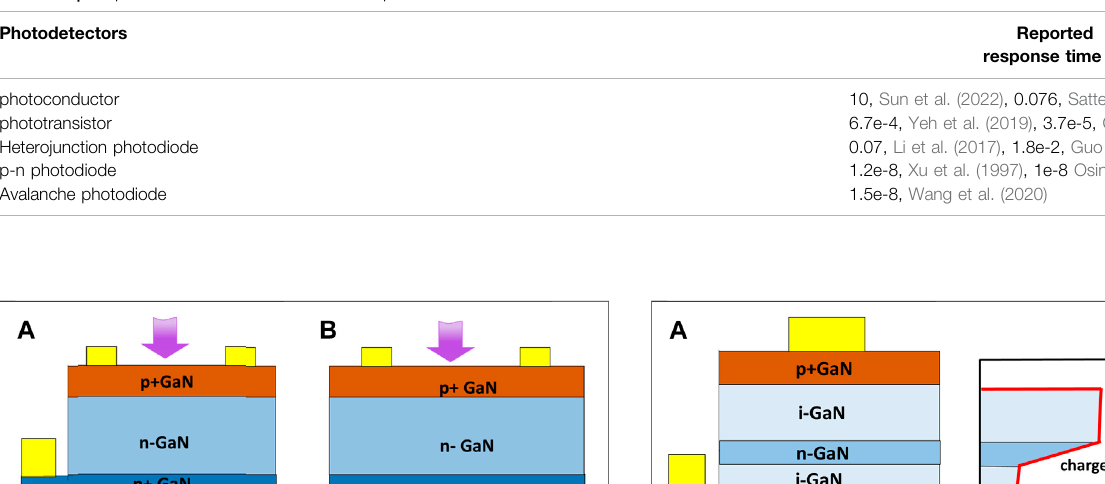
TABLE 4 | Response times of various GaN based photodetectors.